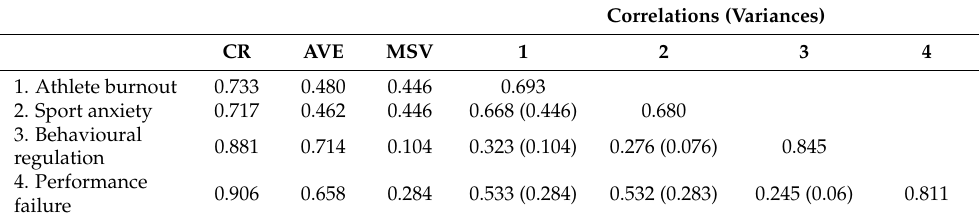
Table 4. Divergent validity of